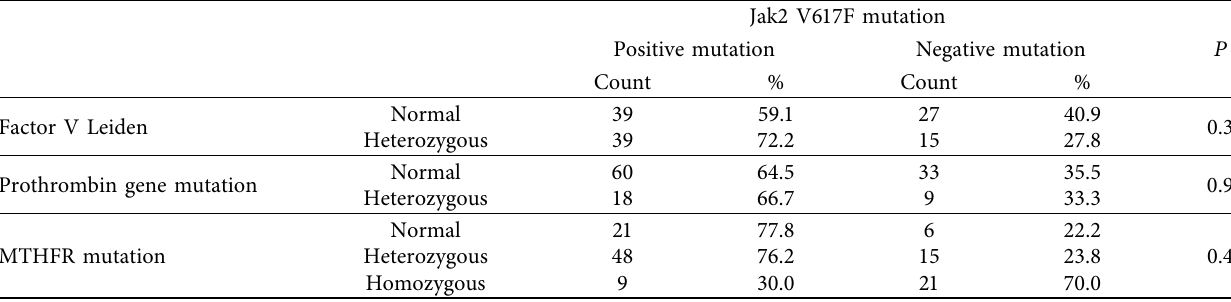
Table 4: Percentage of factor V Leiden, prothrombin gene, and MTHFR mutations in essential thrombocythemia patients with JAK2 V617F positive mutation versus the JAK2 V617F negative group.